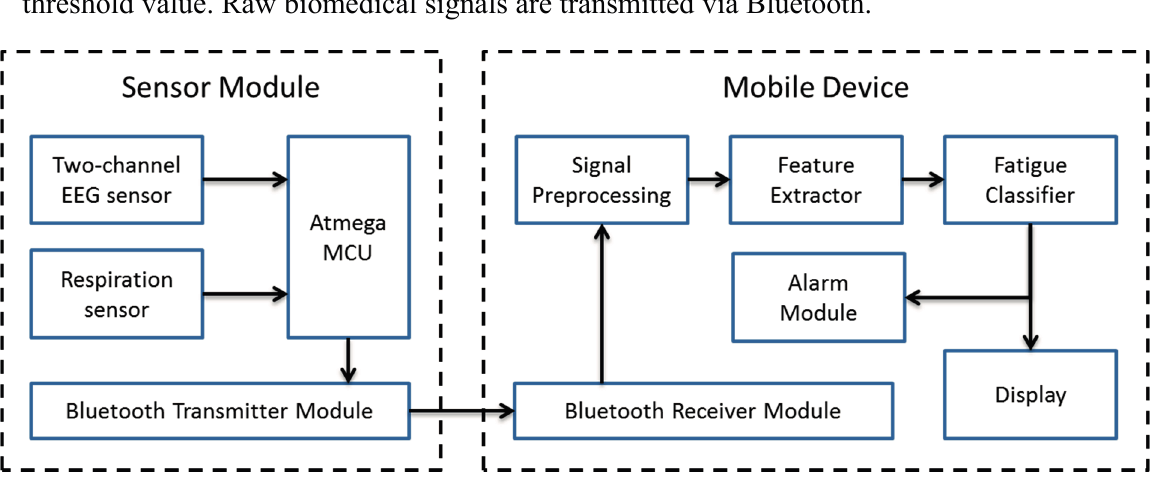
Figure 1. Block diagram of the proposed system architecture for